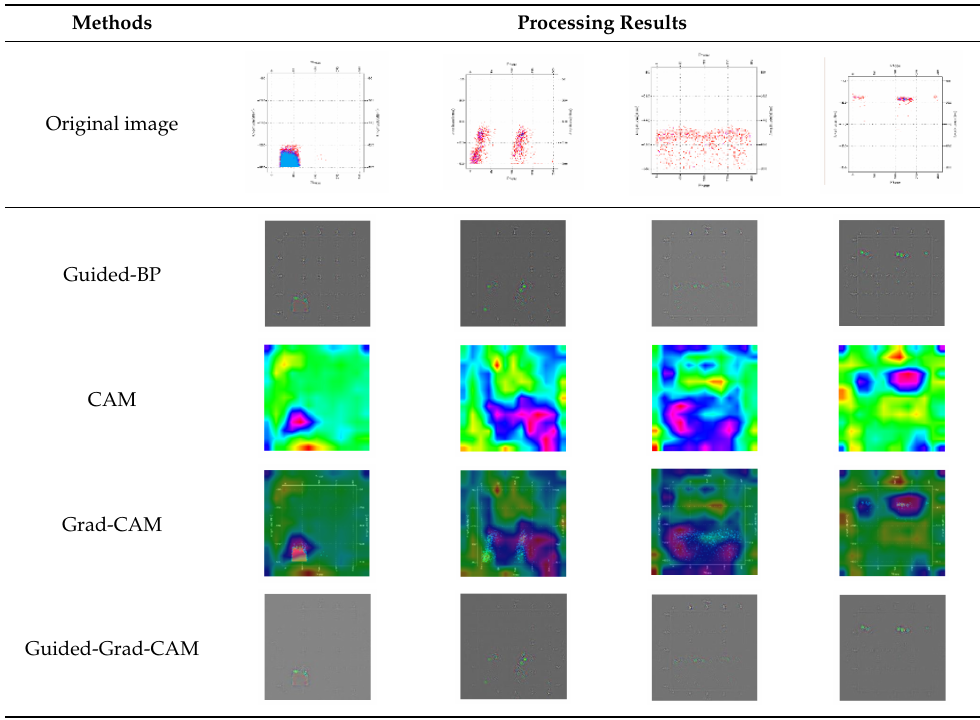
Table 5. Core module construction of